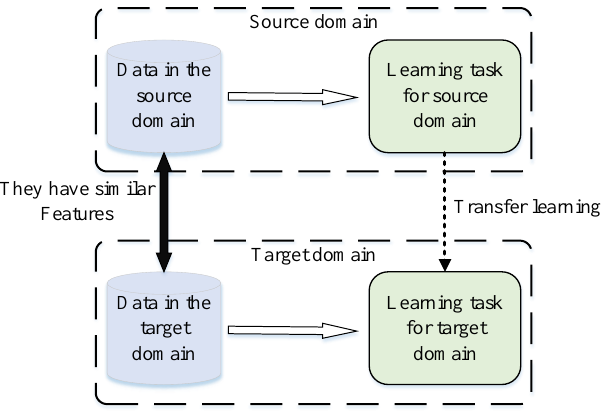
Figure 1. Schematic diagram of transfer learning.